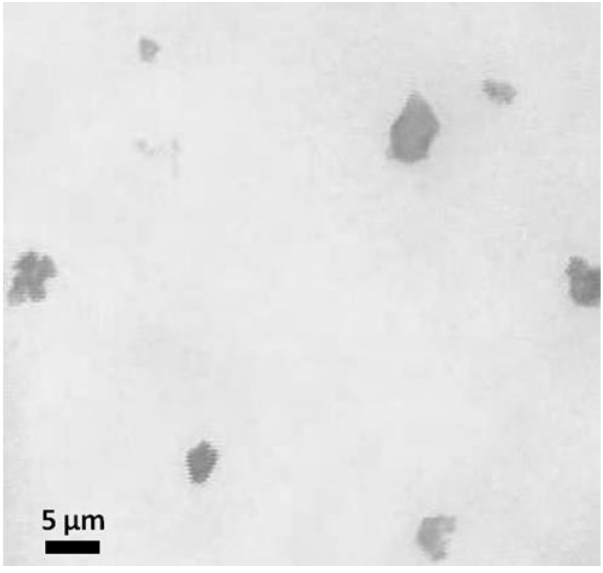
Figure 1. Image of microparticles of extracellular matrix of decellularized rat liver ( × 100, phase